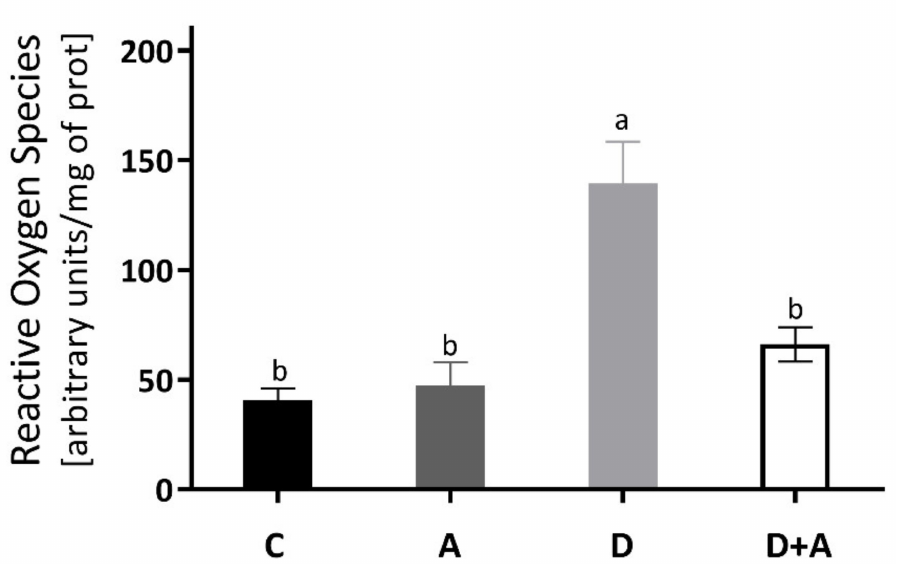
Figure 2. Levels of Reactive Oxygen Species in the heart of different groups of rats. This figure shows the Reactive Oxygen Species ( ∆ F) levels in the heart for each group C = control, A = apocynin, D = diabetic, D+A = diabetic + apocynin. n = 6; Data are presented as the mean ± standard error (One-way ANOVA, Tukey posthoc test). The different letters indicate the significant differences between groups, with p < 0.05.